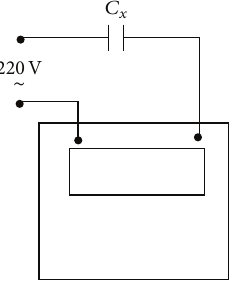
Figure 3: The installation wiring diagram where the woven fabric represents the equivalent of a capacitor ( 𝐶 𝑥